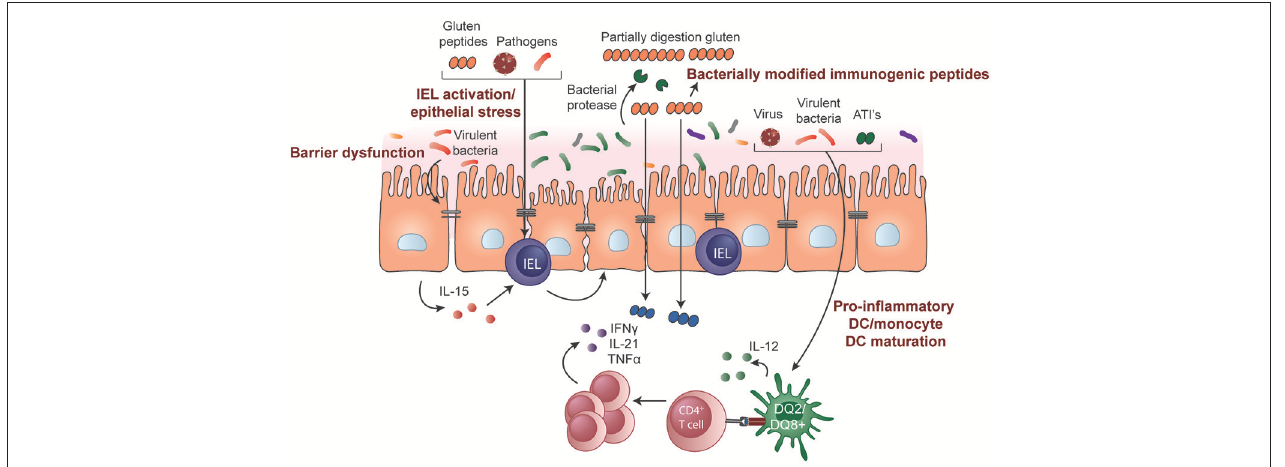
FIGURE 2 | Potential role of microbes and environmental triggers in CeD pathogenesis. Microbes that include both commensals and opportunistic pathogens may contribute to the development of CeD by influencing gluten peptide digestion, intestinal barrier function, epithelial cell stress, or IEL activation/upregulation through IL-15 regulation. Pathogenic bacteria, viruses, and non-gluten components of wheat, such as amylase-trypsin inhibitors (ATIs), may also induce DC maturation and proinflammatory cytokine production, modulating the induction of CD4 + T-cell responses.